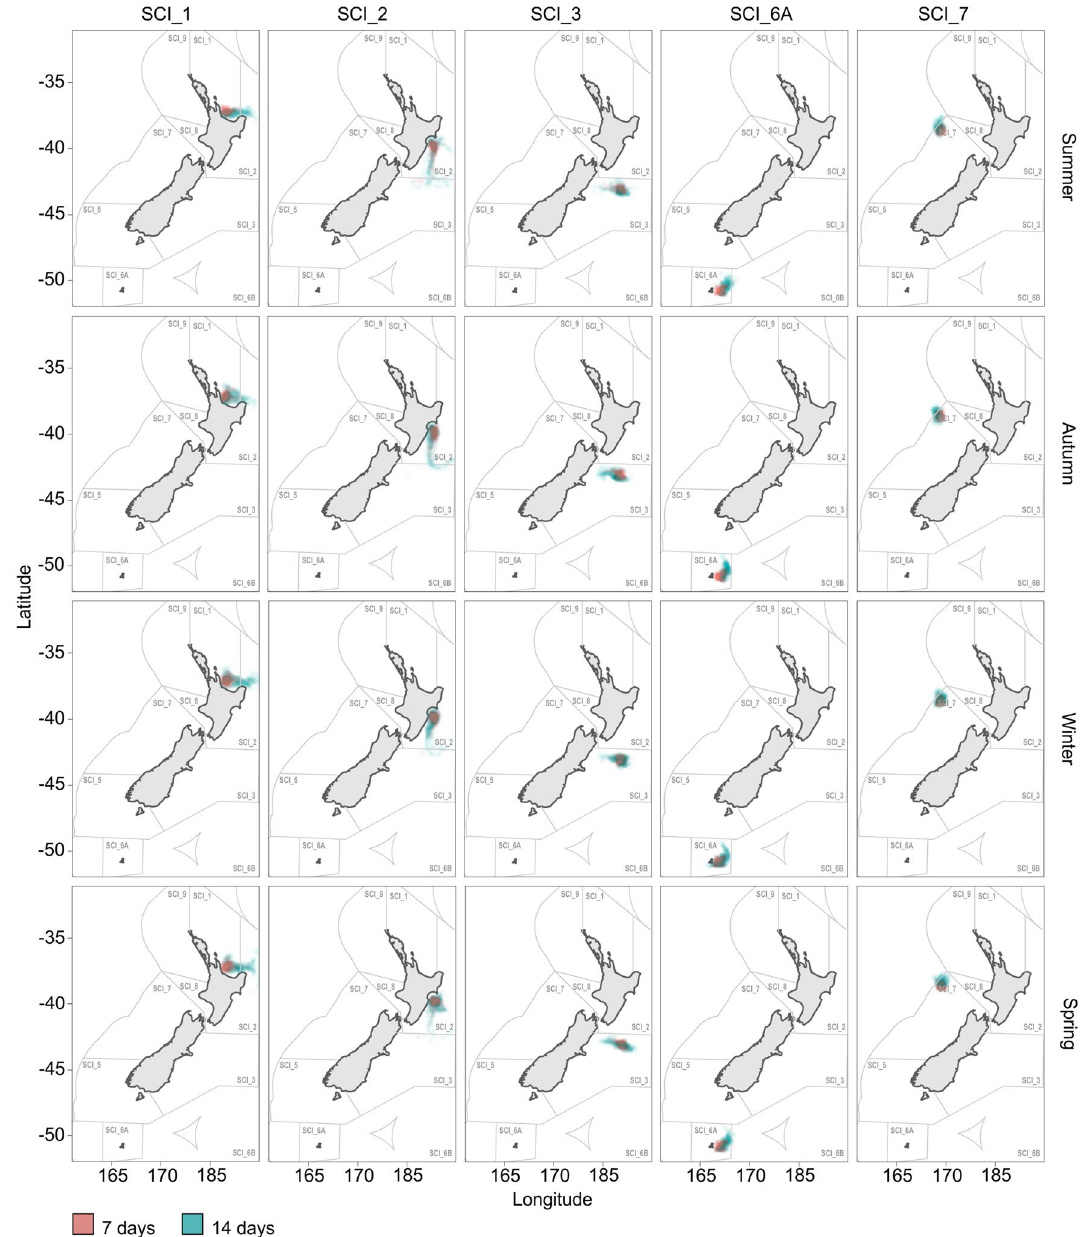
(pink) and 14 (blue) days. Plotted is a random selection of 20,000 particles that were released divided equally per SCI, and their movement captured by season of release. The figure’s main elements, i.e., New Zealand and position of particles, were generated with ggplot2 v3.3.3 114 and rnaturalearth v0.1.0 117 . Other aesthetic elements were added using Corel Draw Essentials X5